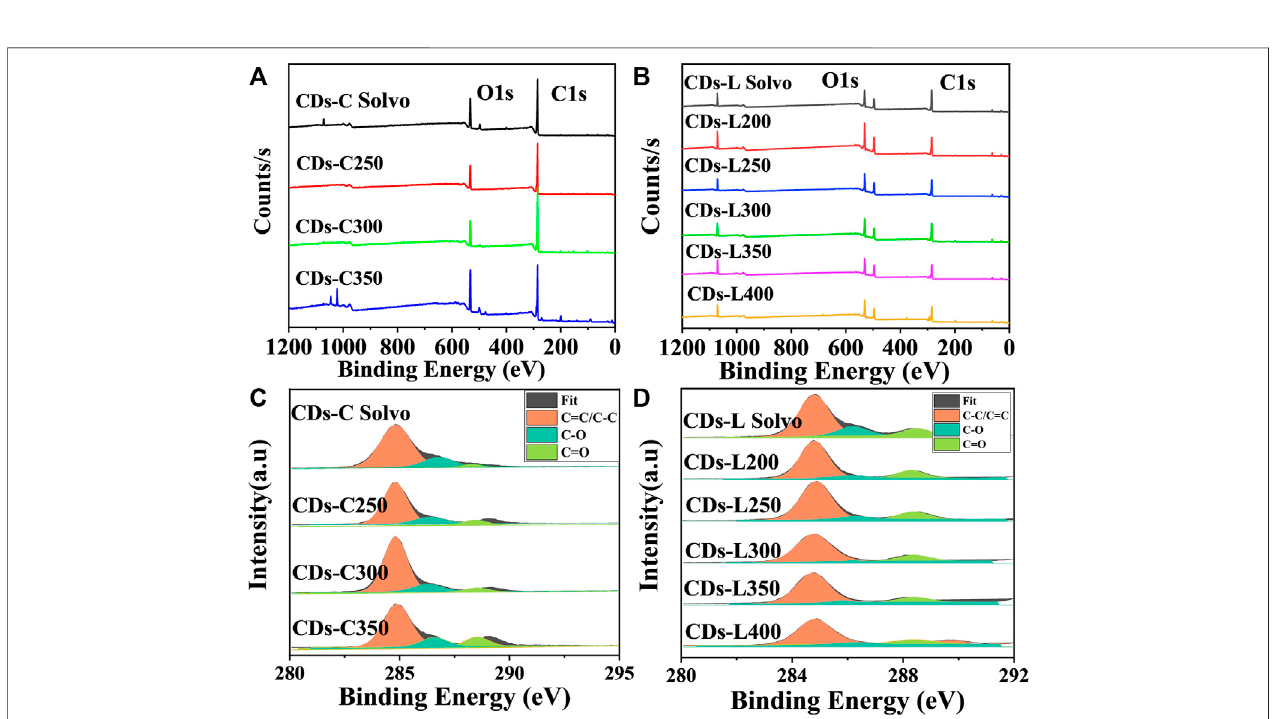
FIGURE 6 | (A,B) XPS survey spectra, and (C,D) high-resolution C 1s spectra of CDs-C Solvo, CDs-C 250 – 350, CDs-L Solvo and CDs-L 200 – 400.